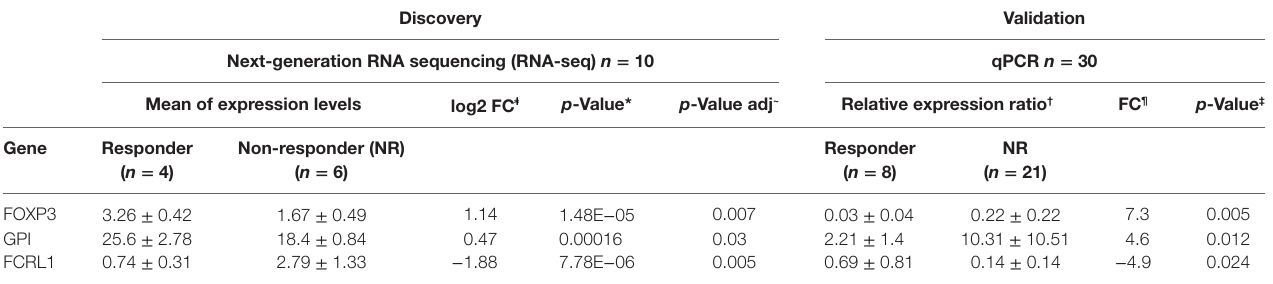
TaBle 2 | Quantitative PCR (qPCR) validation of differentially expressed genes in RNA-seq results.